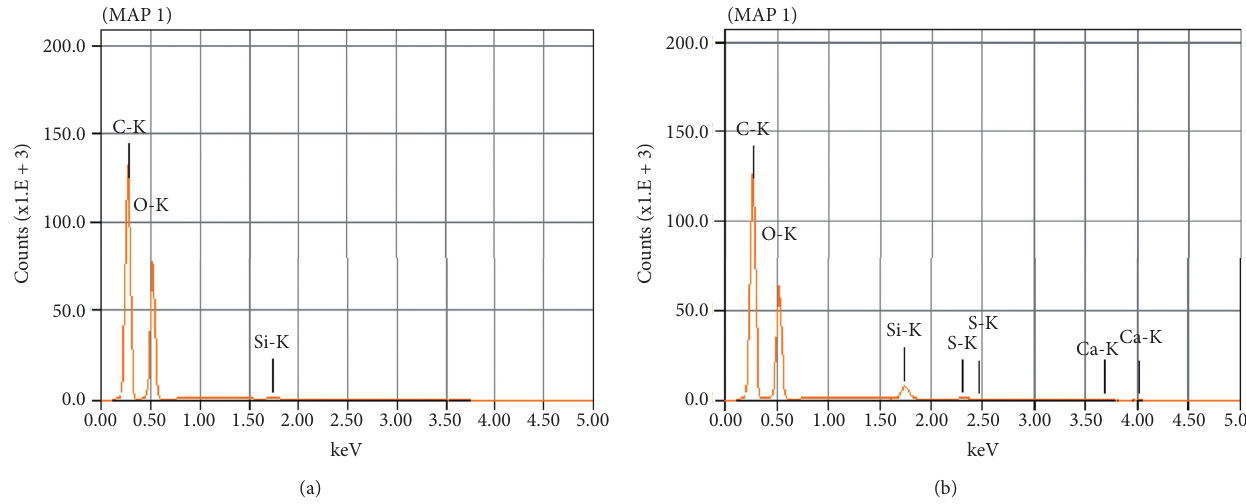
Figure 5: Energy dispersion spectrometer (EDS) of RVP of center position 1/4: (a) fiber/matrix border and (b) fiber. Table 1: Summary of mass percentages of RVP chemical elements.